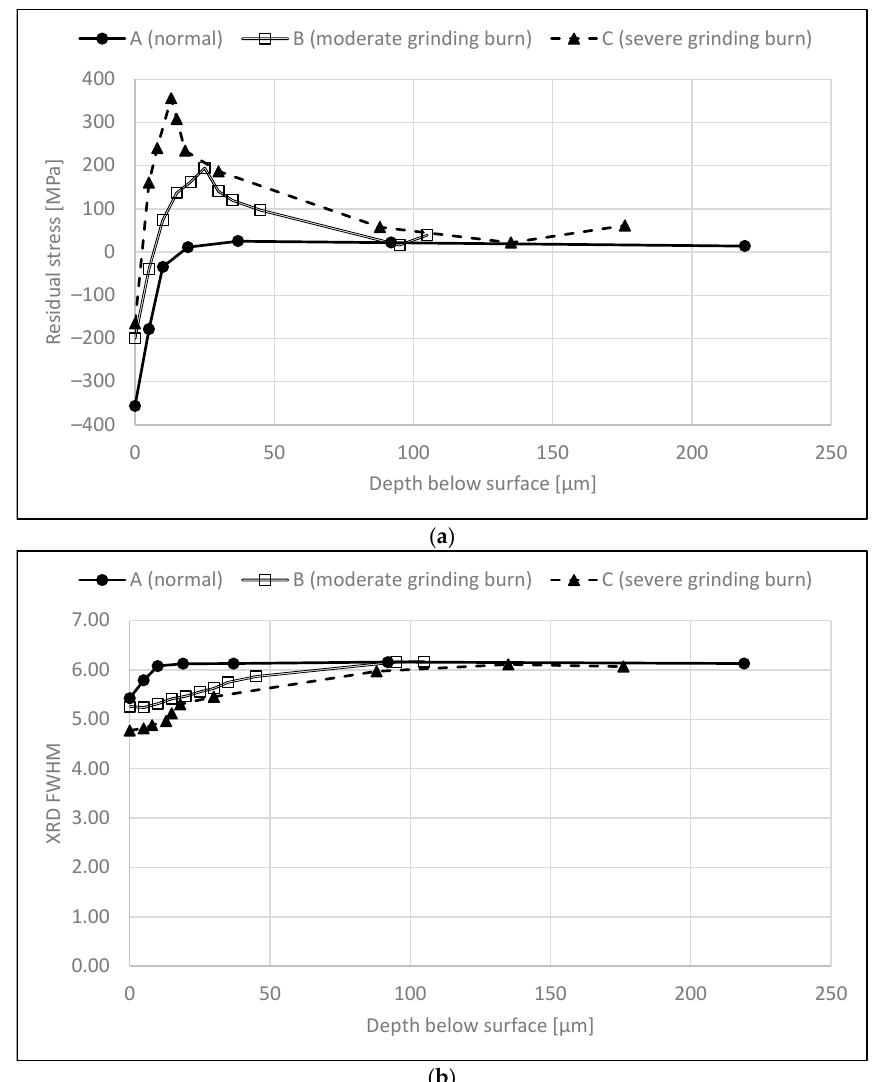
Figure 2. Examples of ( a ) residual stress profiles and ( b ) XRD FWHM profiles. The measurements were carried out in the tangential direction. A refers to a normal profile (surface RMS 60), B refers to a moderate grinding burn (surface RMS 73) and C refers to a severe grinding burn (surface RMS 74).